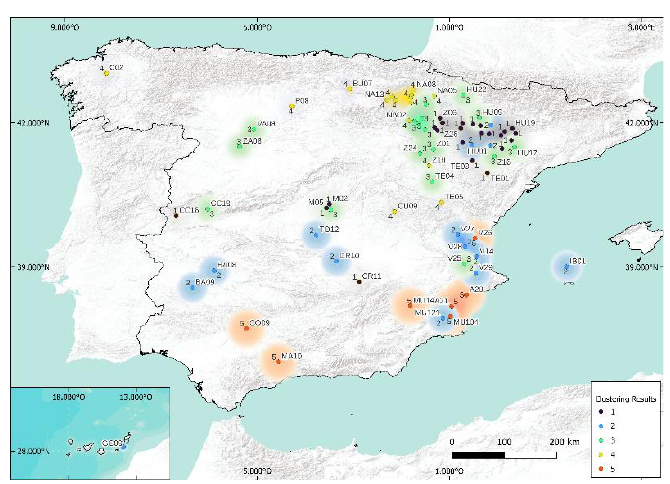
Figure 14. Using spectral for 5 clusters.